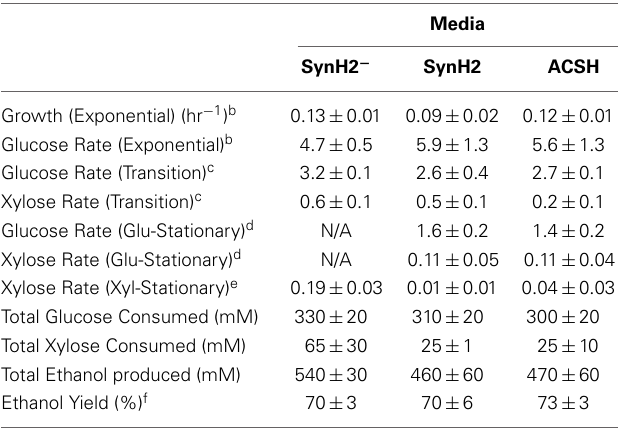
Table 2 | Growth, sugar uptake, and ethanol production by GLBRCE1 grown in ACSH and SynH2 − , and SynH2 a